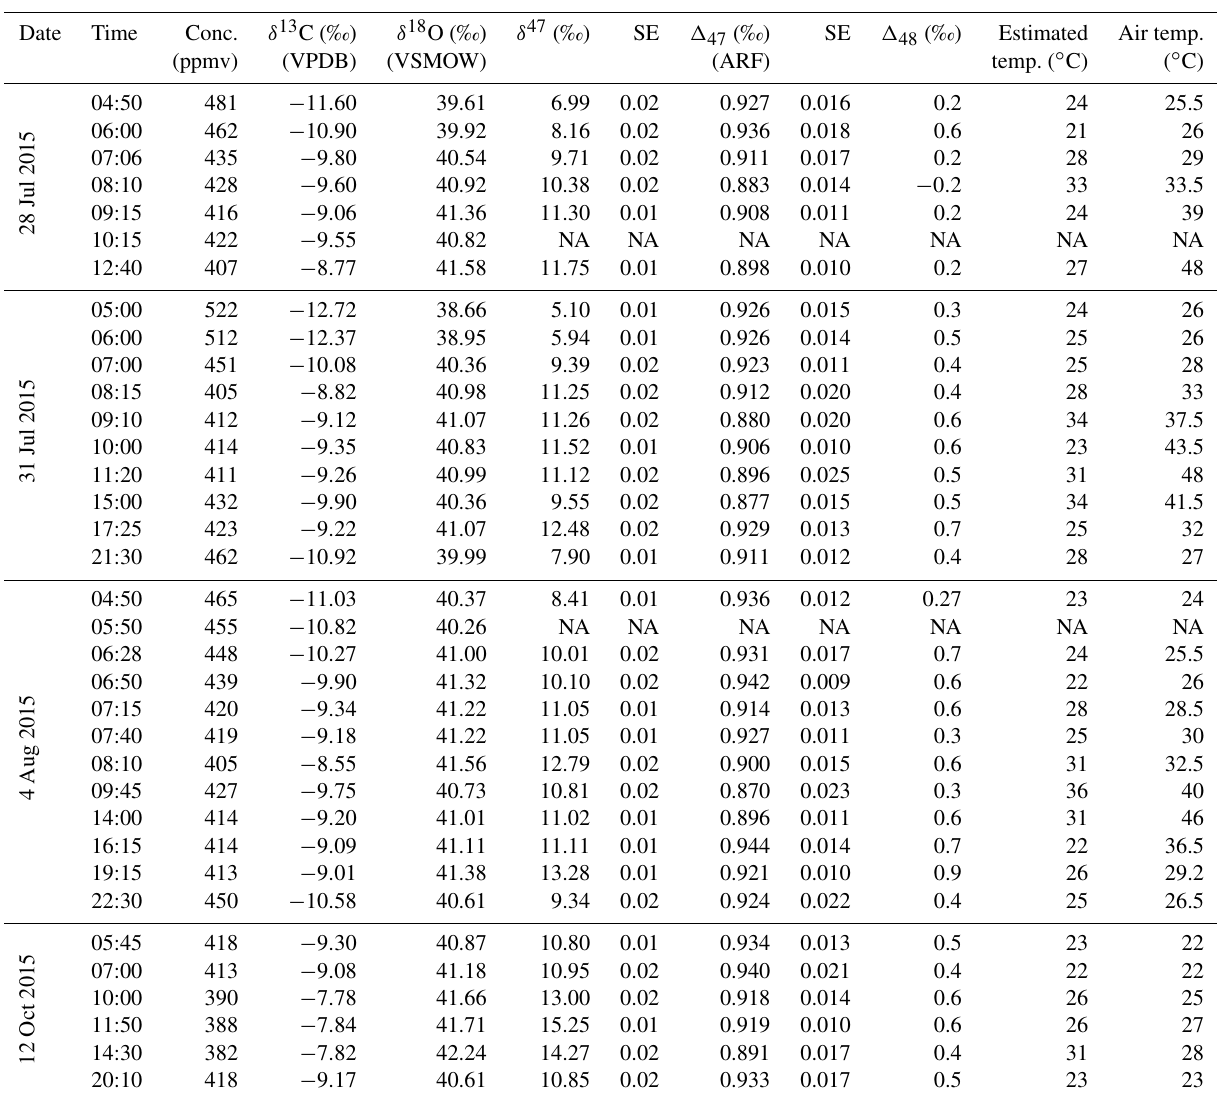
Table 1. Diurnal variation of δ 13 C and δ 18 O and clumped isotopes ( (cid:49) 47 ) for greenhouse CO 2 . Temperatures estimated using (cid:49) 47 values and actual air temperatures inside the greenhouse at the time of sampling are also